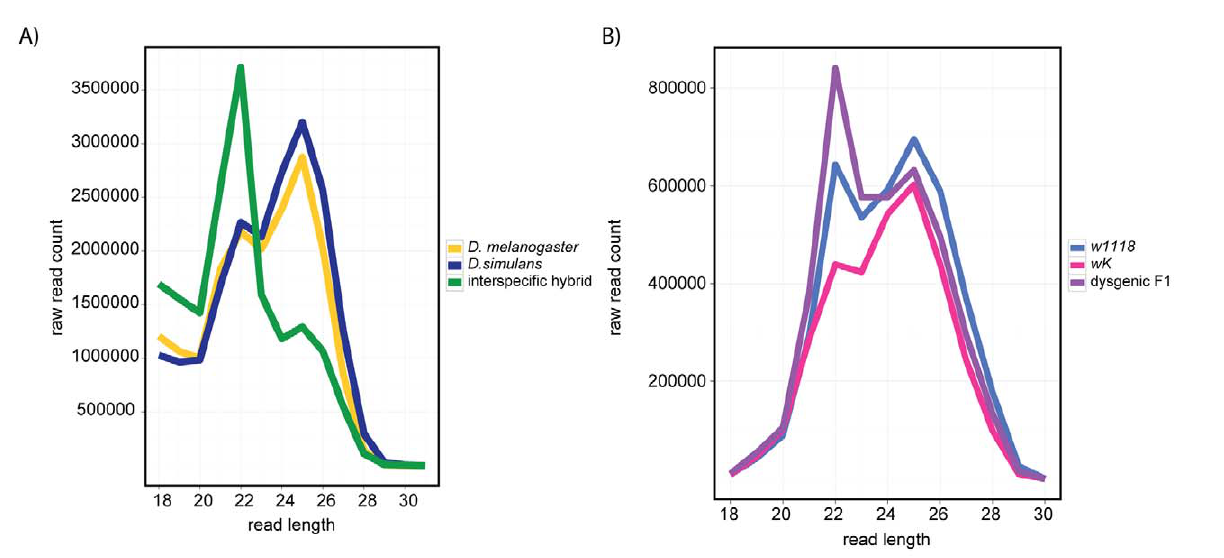
Figure 4. Small RNA pools from interspecific hybrids, but not intraspecific hybrids, are depauperate for (23–29 nt) piRNAs. (A) Size distribution of small RNAs from D. melanogaster (yellow), D. simulans (blue), and interspecific hybrid (green) ovaries. (B) Size distribution of small RNAs from w K (pink), w 1118 (blue), and their F1 dysgenic intraspecific hybrid (purple) ovaries.